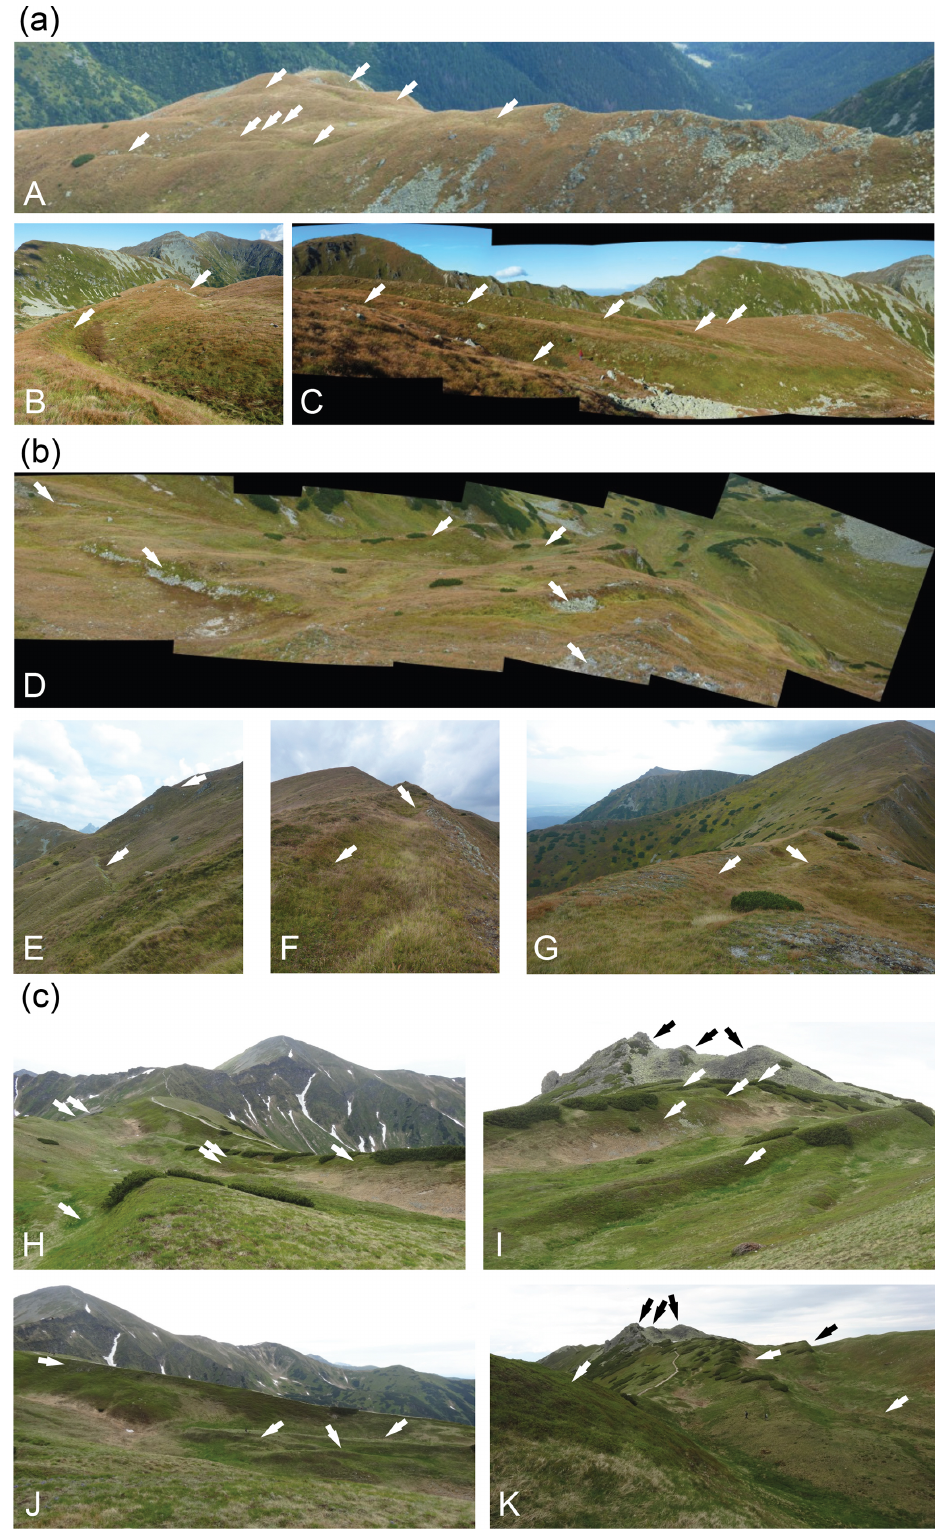
Figure 5. Field photographs of the Tatra sites (located in Fig. 4): (a) Site T1; (b) Site T2; (c) Site T3. Arrows indicate some of the DSGSD